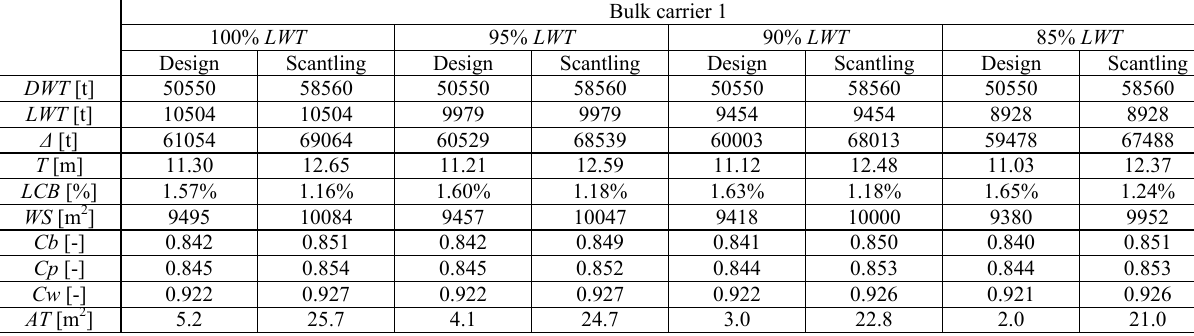
Table 10. Input parameters for HM method (bulk carrier 1)